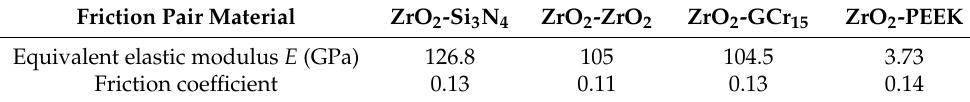
Table 4. Equivalent elastic modulus and friction coefficient of different friction pair combinations. Friction Pair Material